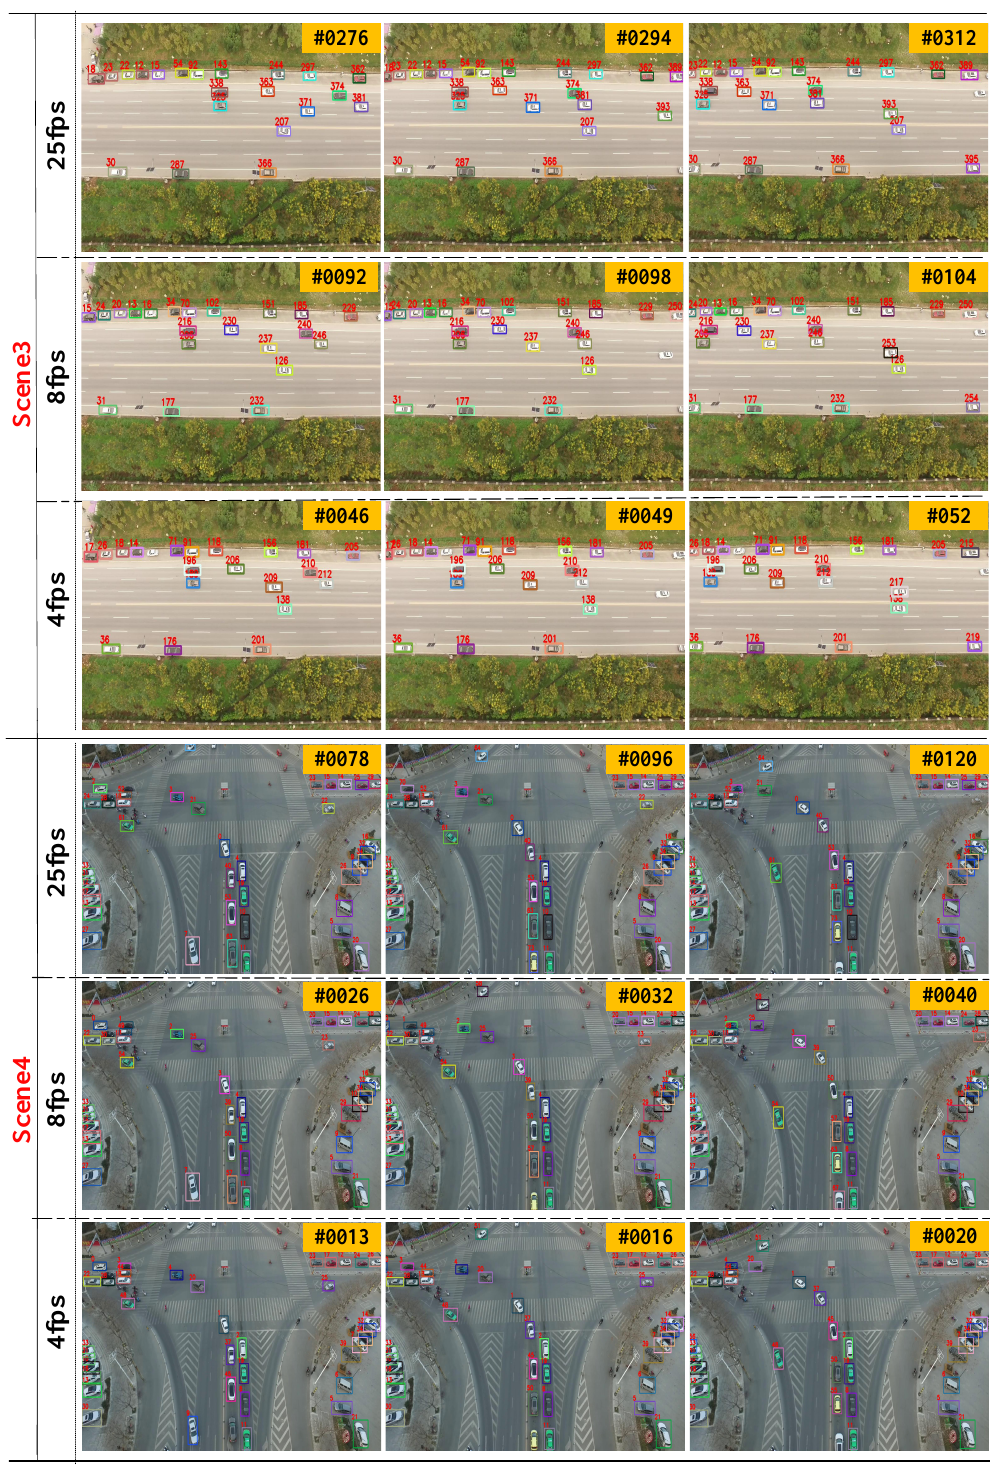
Figure 8. Tracking results at three different frame rates in Scenes 3 and 4. Scene 3 is a busy road and Scene 4 is a crosroad. There were many targets in these two scenarios that were prone to target adhesion. Moving state of the target was also complex, such as stationary, straight driving, turning a corner, and turning